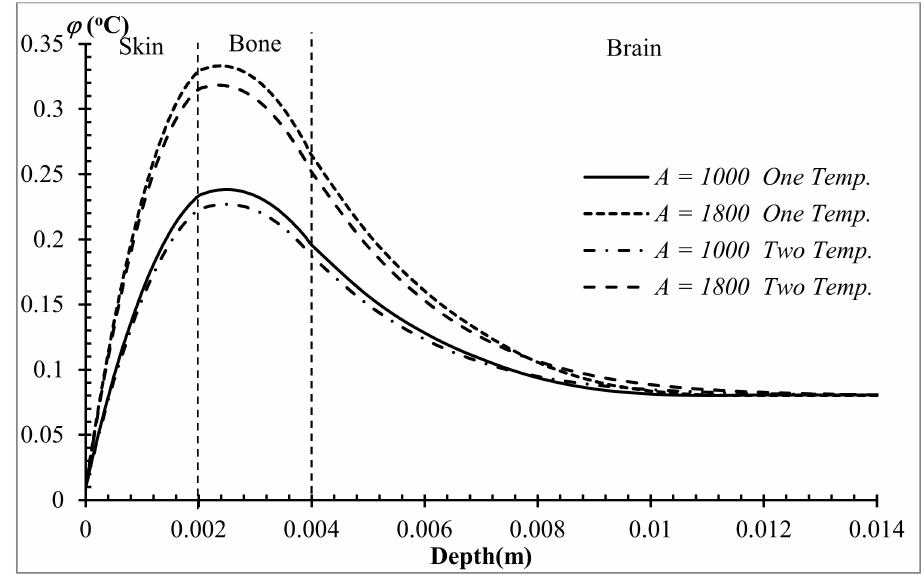
Figure 5. The conductive temperature increment with the various frequency on a child’s